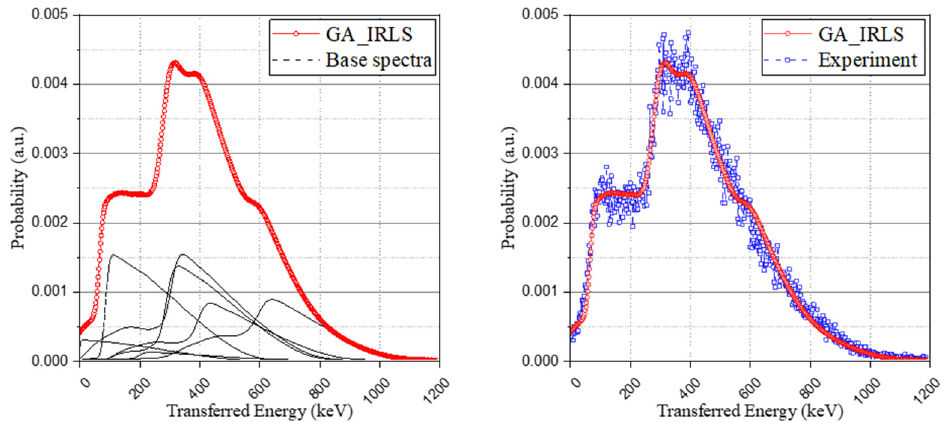
Figure 6. Configuring the genetic algorithm-based IRL spectrum (GA_IRLS) with weighted base spectra ( left ) and the validation of the study with experimental IRL spectrum ( right ).